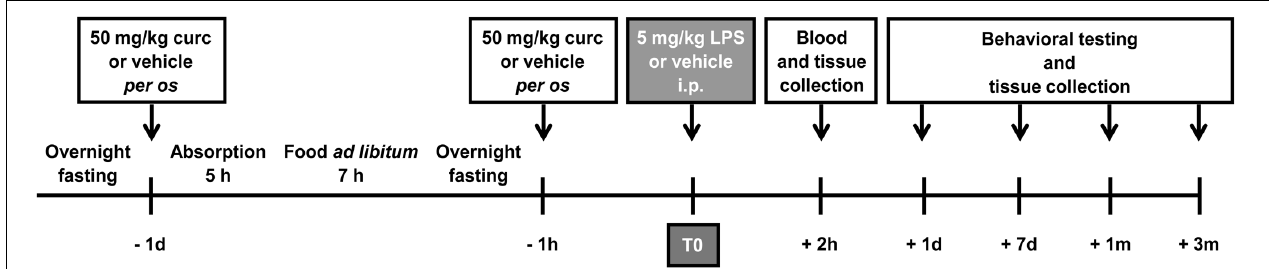
FIGURE 1 | Schematic representation of the experimental design of this study. Mice treated for 2 consecutive days with curcumin (curc; 50 mg/kg) received a single intraperitoneal (i.p.) injection of LPS (5 mg/kg). Control animals received per os the same volume of vehicle following the same time schedule and were then injected i.p. with saline. At different times after LPS administration, behavioral tests were performed and blood samples and brain tissues were collected for analysis.